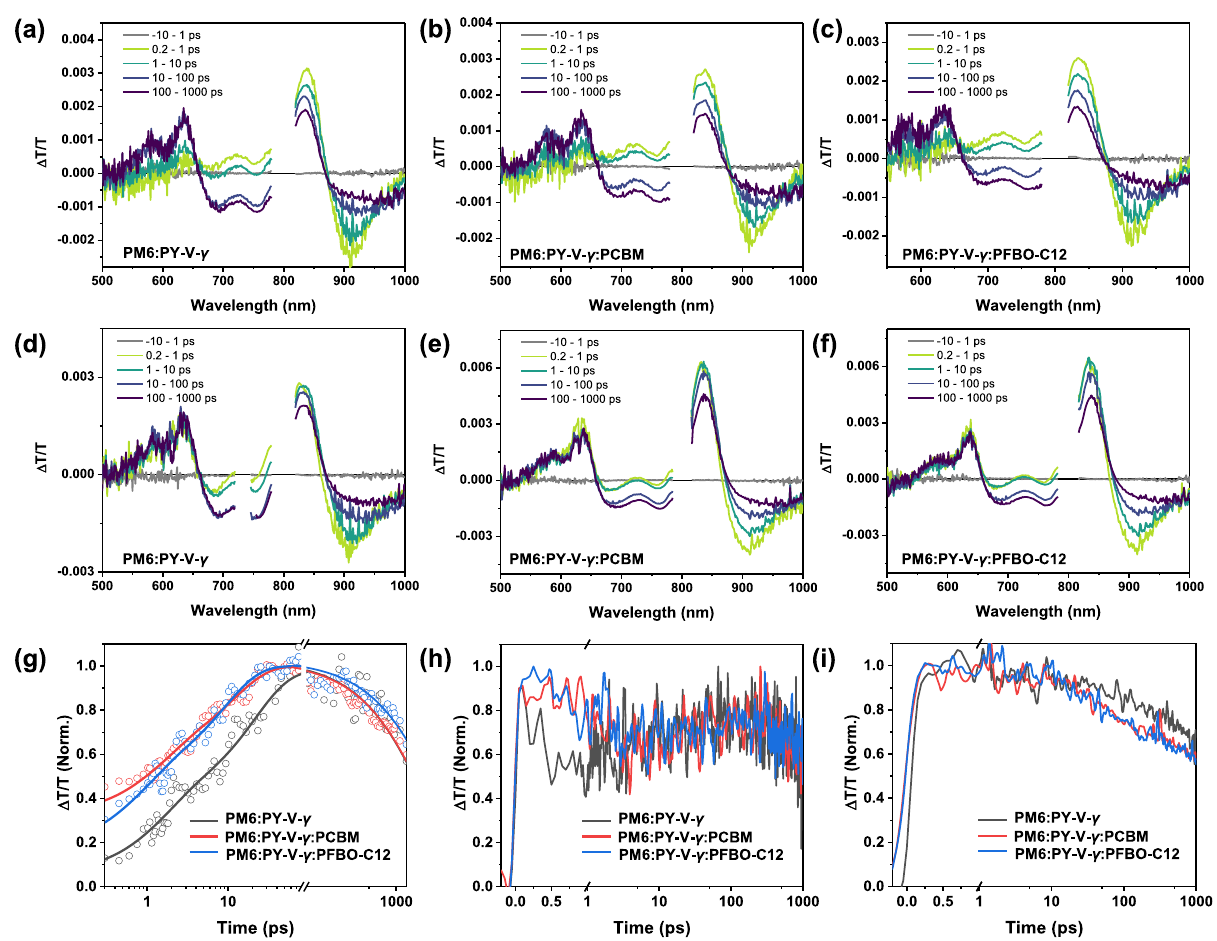
Fig. 4 | Exciton and charge dynamics. Transient absorption spectra (TAS) of a PM6:PY-V- γ , b PM6:PY-V- γ :PCBM,and c PM6:PY-V- γ :PFBO-C12blend fi lmsexcited at 800nm. TAS of d PM6:PY-V- γ , e PM6:PY-V- γ :PCBM, and f PM6:PY-V- γ :PFBO-C12 blend fi lmsexcitedat370nm.KineticsofGSBofPM6(630 –